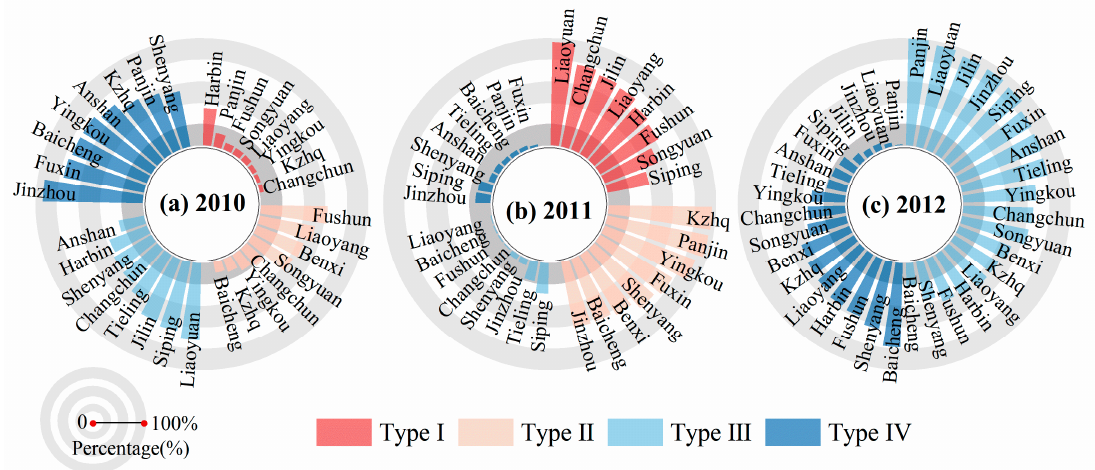
Figure 6. The area proportions of the four coupling types of drought and waterlogging in the maize croplands of Songliao Plain (The proportions of the coupling types of drought and waterlogging for 2000–2020 are shown in Supplementary Figure S1). ( a ) and ( b ) are the top eight percentages of